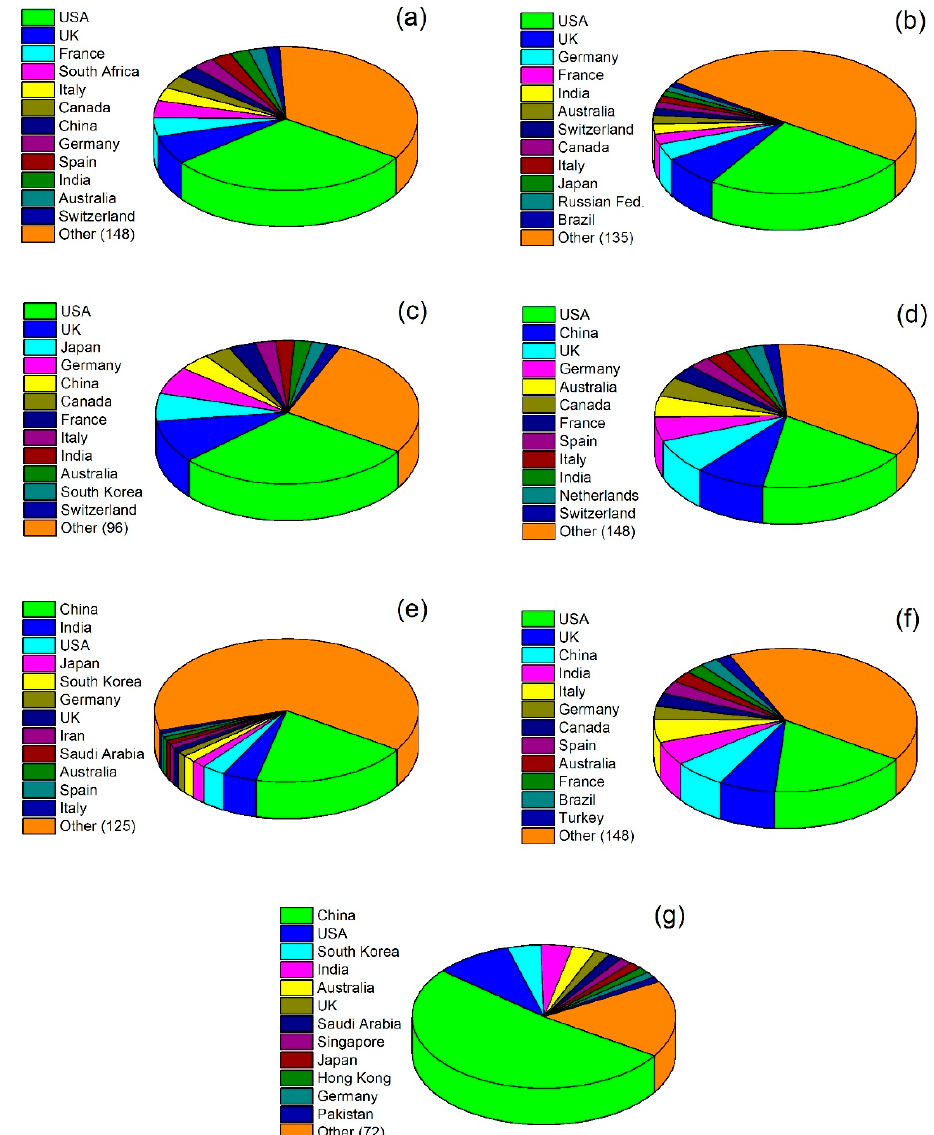
Figure 4. Pie charts representing the share of documents published by country (i.e., researchers affiliated to institutions of each country) by keywords: ( a ) HIV; ( b ) smallpox, ( c ) chlorofluorocarbon; ( d ) climate change; ( e ) photocatalysis; ( f ) COVID-19; ( g ) MXene.